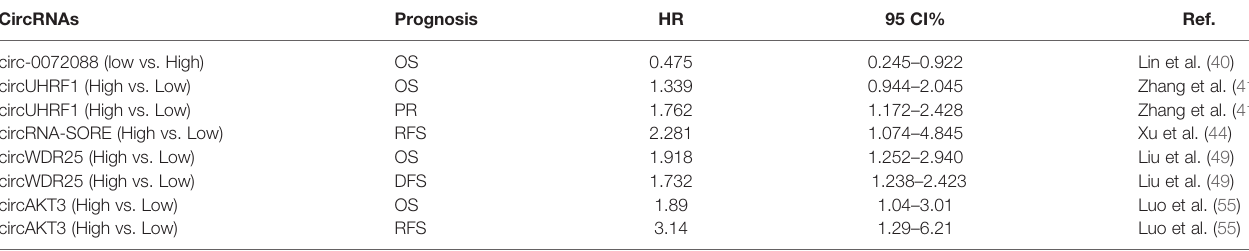
TABLE 4 | Exosomal circRNAs serve as potential prognostic biomarkers for HCC. CircRNAs